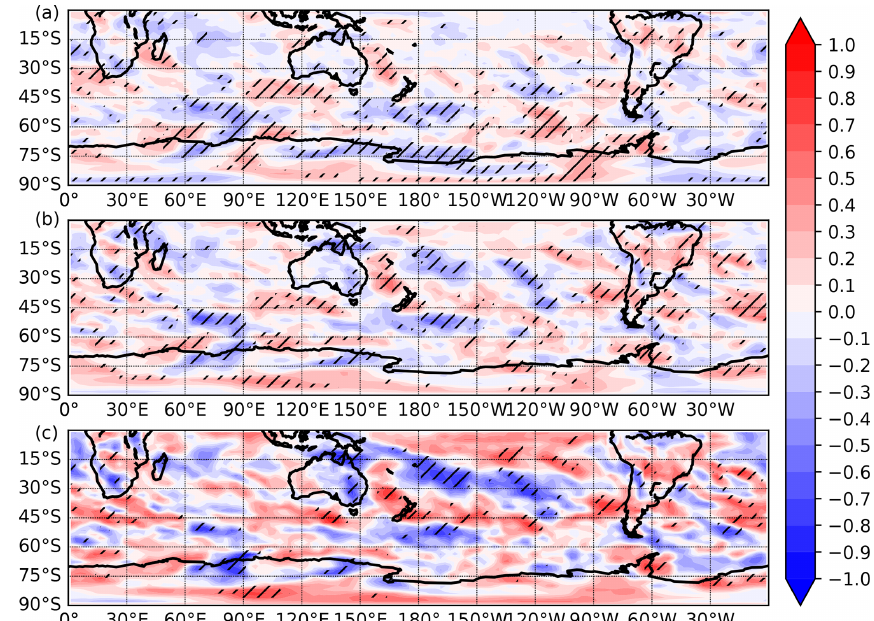
Figure 11. Correlation between the (a) 31 year, (b) 61 year, and (c) 91 year SAM–precipitation running correlation at each grid cell and the model-derived n3.4 index. The n3.4 index is filtered with a corresponding 30, 60, and 90 year filter. Hatched regions indicate p < 0 . 05.